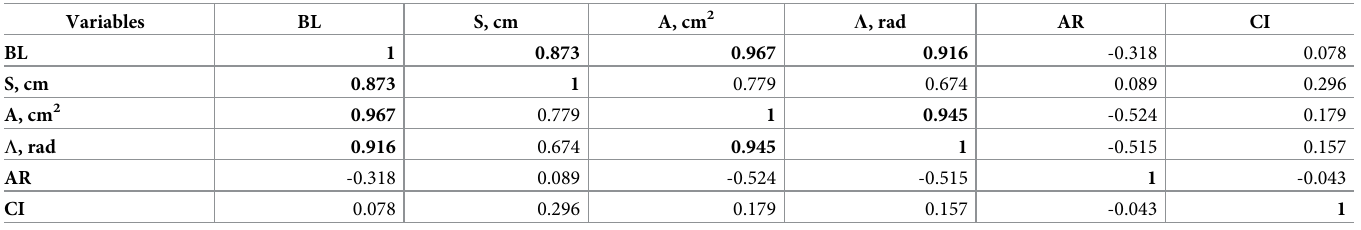
Values in bold are different from 0 with a significance level alpha =